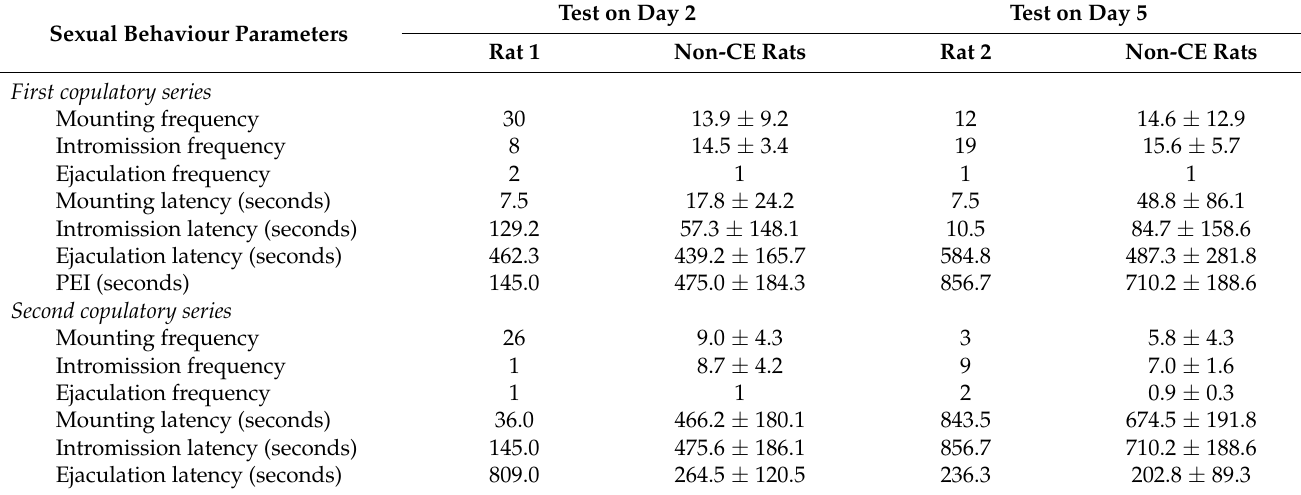
Table 1. Sexual behaviour of male rats on the day when they displayed CE. Parameters of non-CE rats on the same day (mean ± standard deviation) are also presented next to each CE rat’s